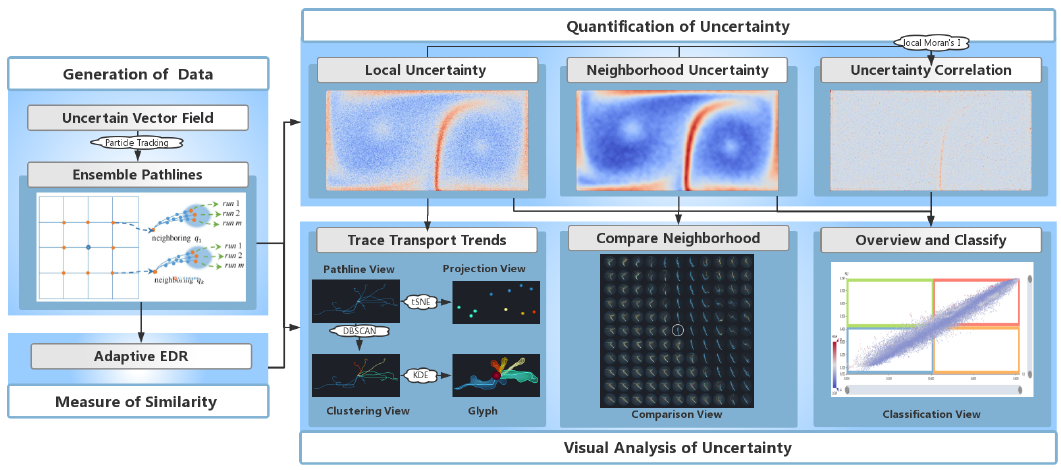
Figure 1. Workflow of analyzing uncertainty in a time-varying ensemble vector